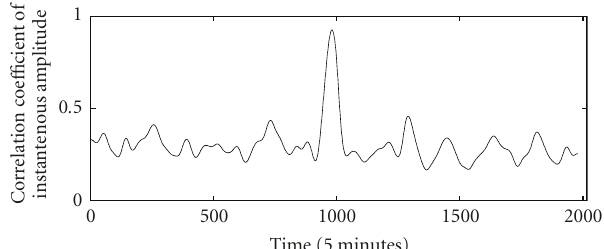
Figure 9: Global correlation coe ffi cient of instantaneous amplitude in no.26, 50 OD flows.